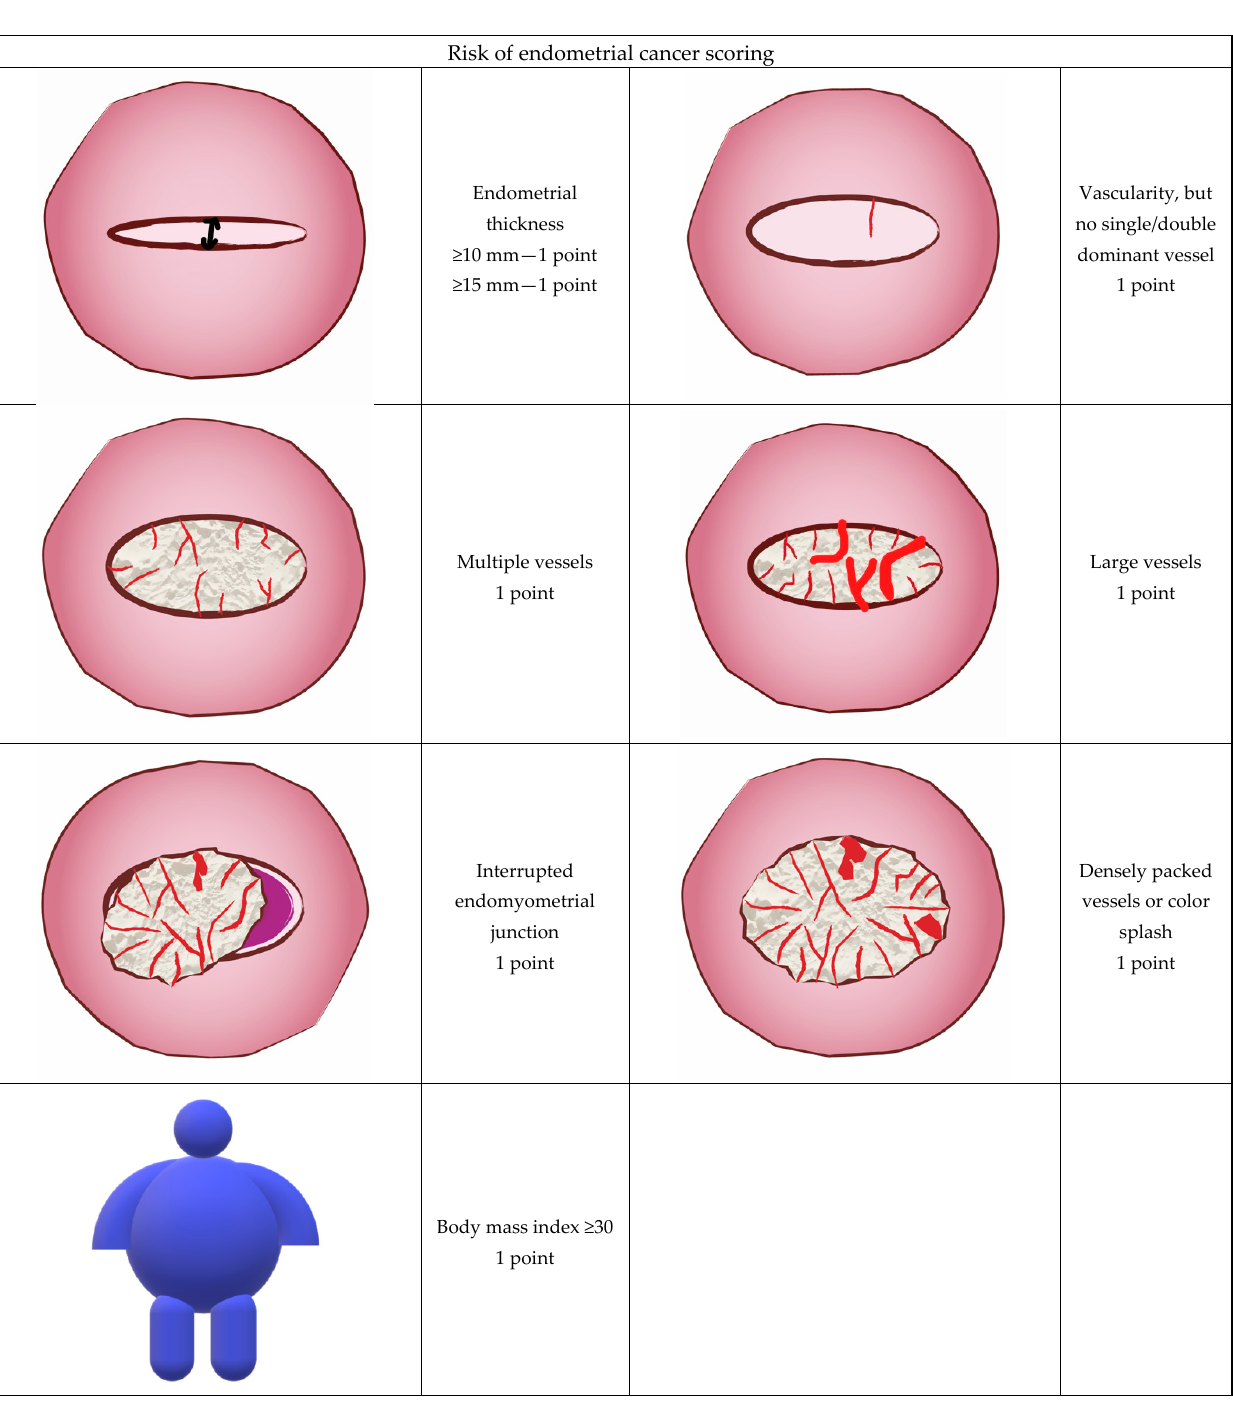
Figure 1. Ultrasound and color Doppler features used to calculate the Risk of Endometrial Cancer (REC) score in the current study. Hysteroscopy or hysterectomy was performed following ultrasound examination